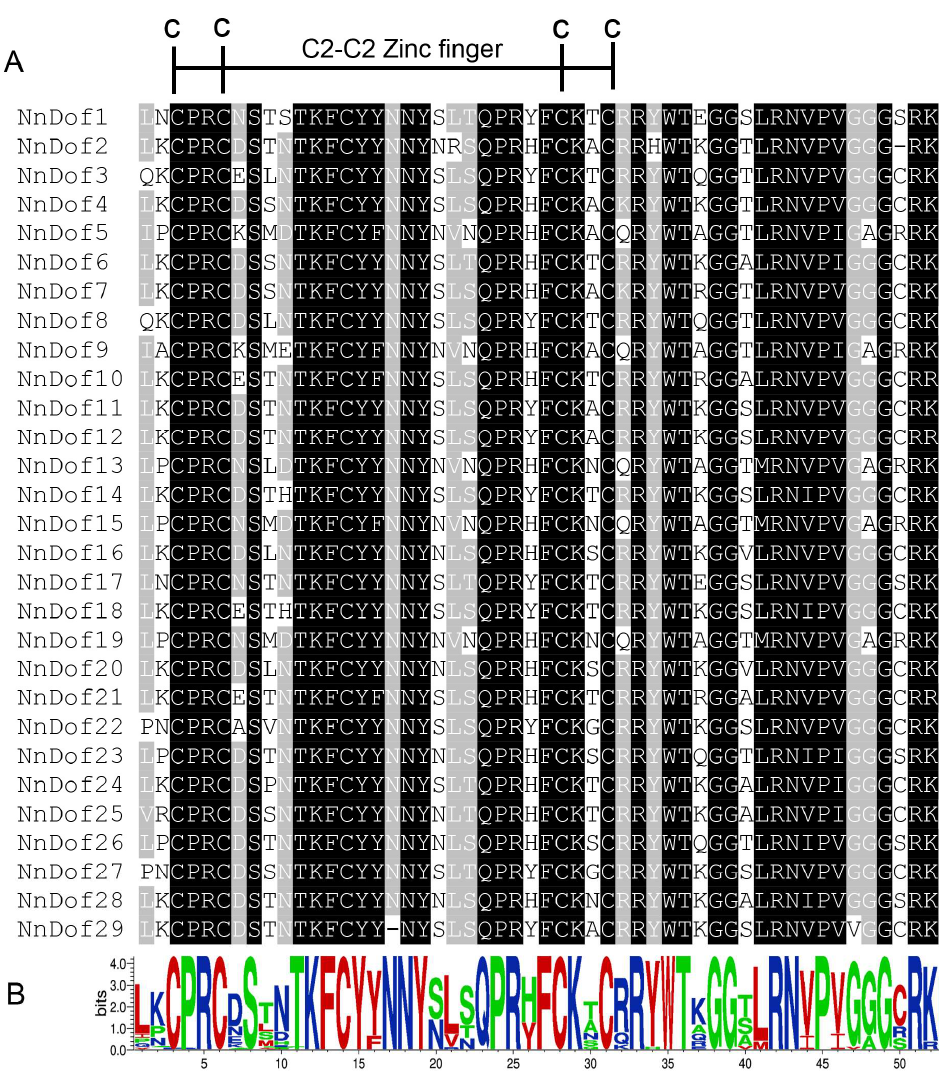
Figure 2. Dof domain sequence alignment of NnDof proteins. ( A ) Extraction of conserved domains of Dof proteins (black region—amino acid homology 100%; grey area—amino acid homology 75%); ( B ) the conserved domains shown by